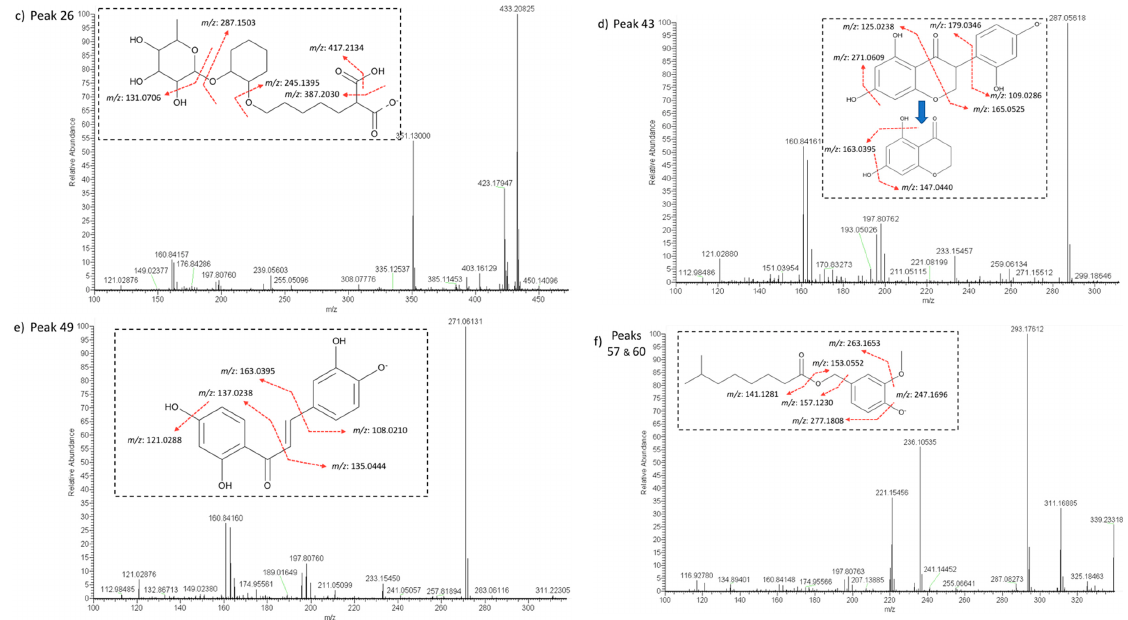
Figure 2. Full scan of some metabolites identified for the first time in C. macromeris . Dotted inset represents the molecule and red dotted lines in each inset represent the proposed fragmentation pattern. Peak numbers in each figure, refer to the compounds indicated in Table 1.